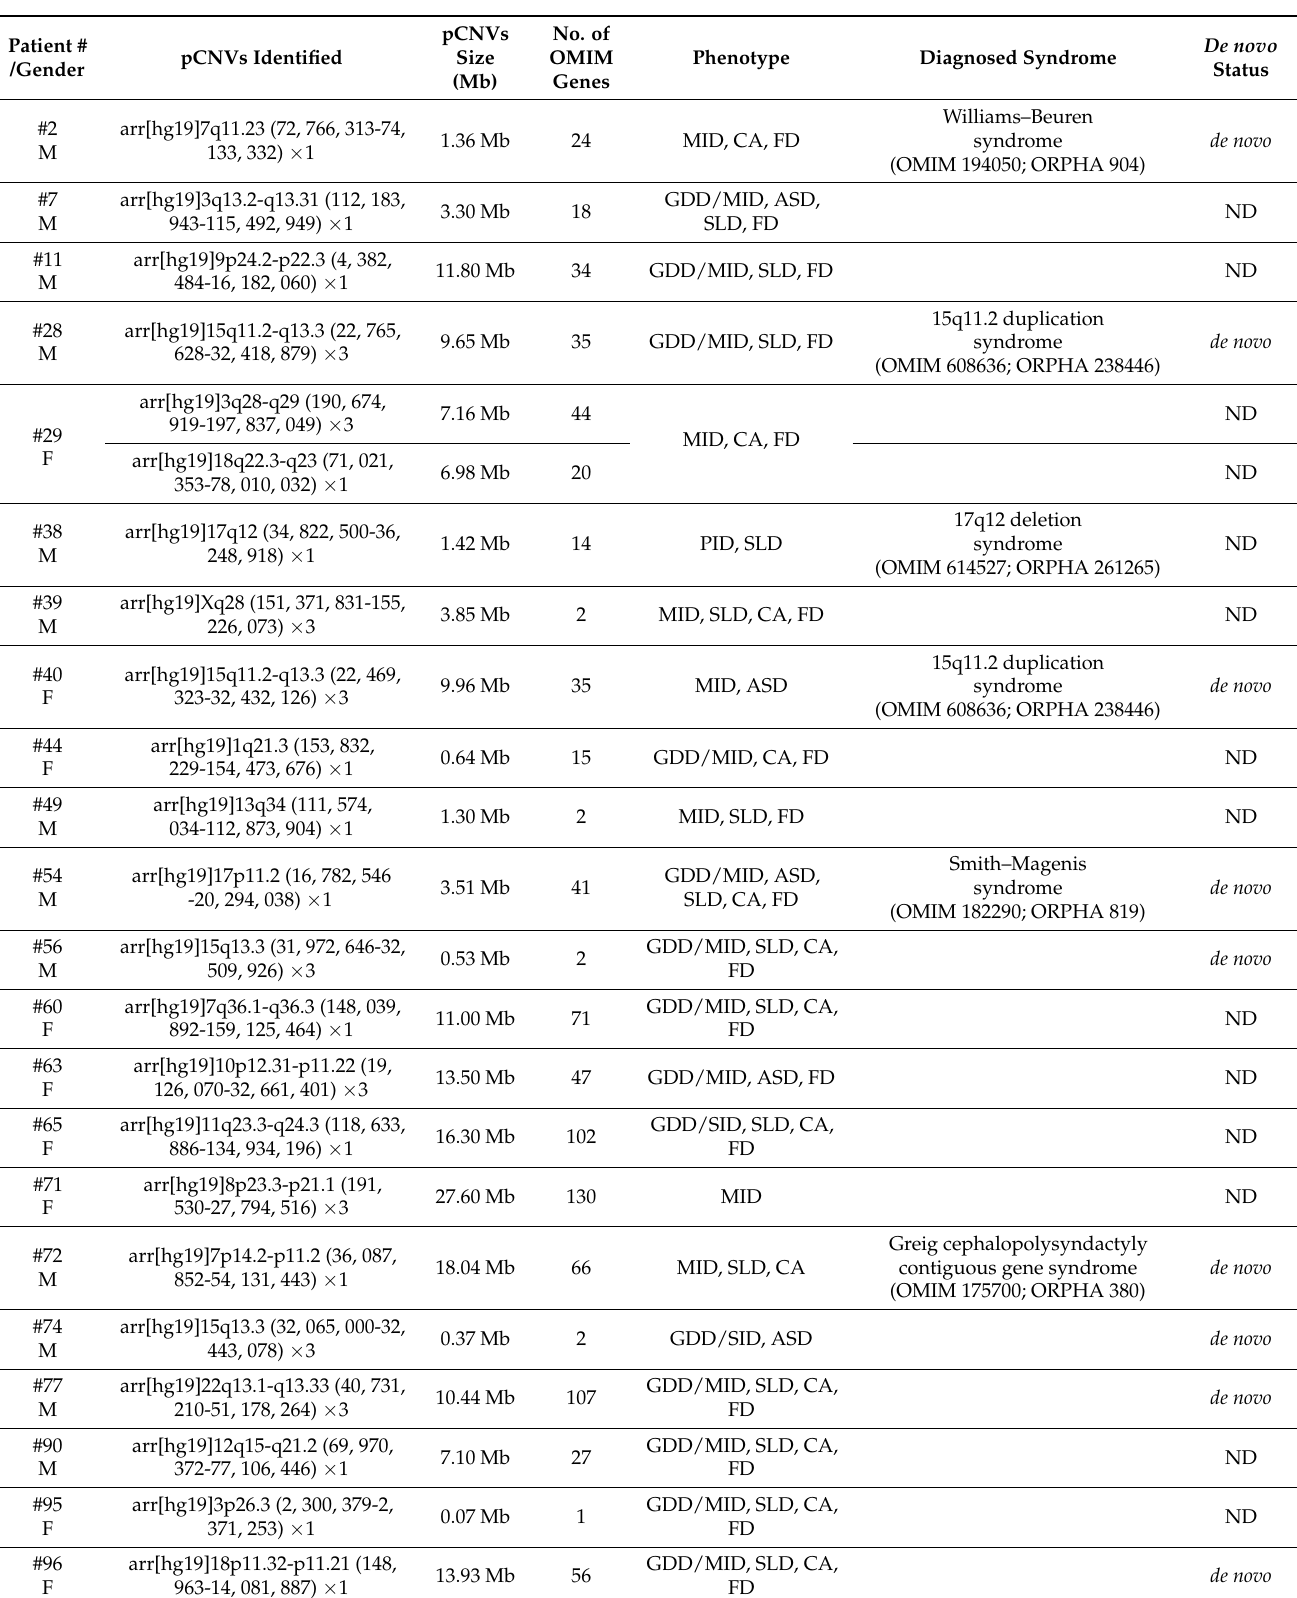
Table 1. pCNVs identified in our cohort. pCNVs found by CMA in the cohort, with the number of OMIM genes present in the region, listing the phenotypes for each